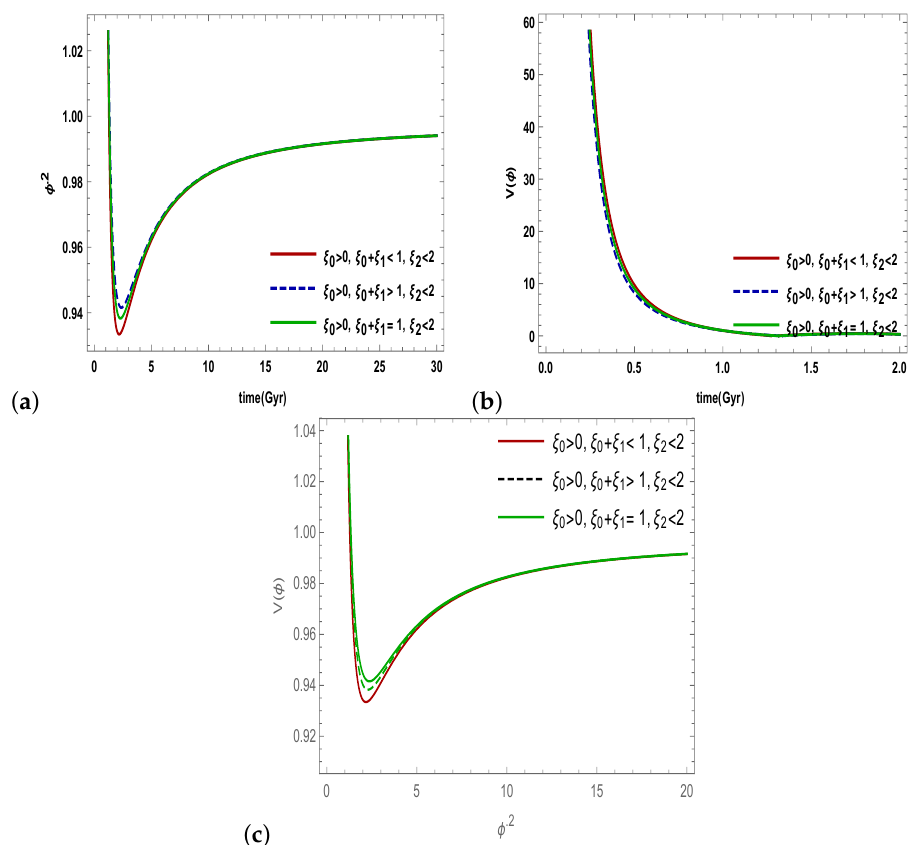
Figure 5. Correspondence of tachyon scalar field and potential versus t for various values of bulk viscosity